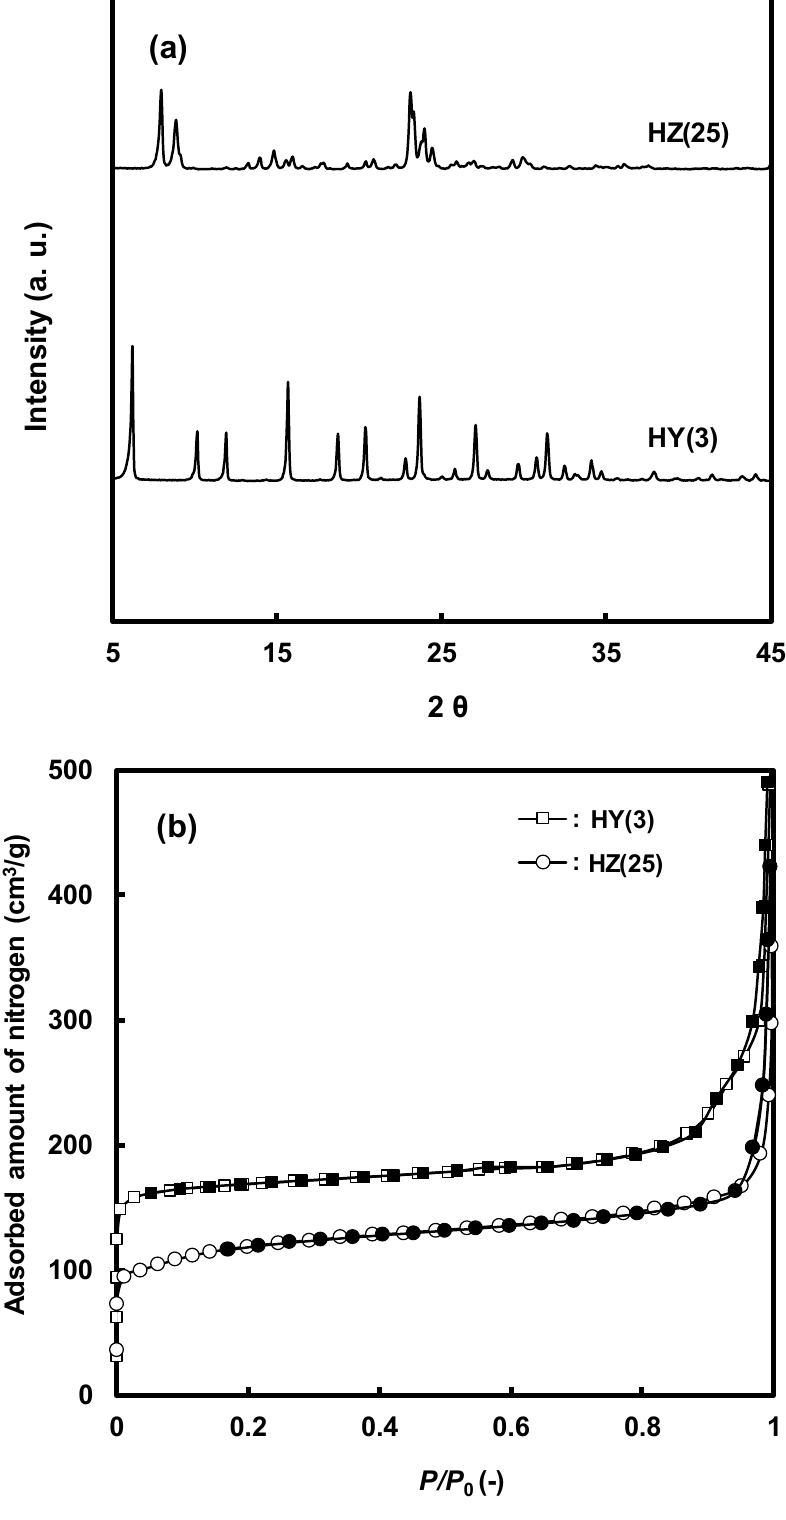
Figure 1. X-ray diffraction (XRD) patterns ( a ) and N 2 isotherms ( b ) of the Figure 1. X ‐ ray diffraction (XRD) patterns ( a ) and N 2 isotherms ( b ) of the zeolites.